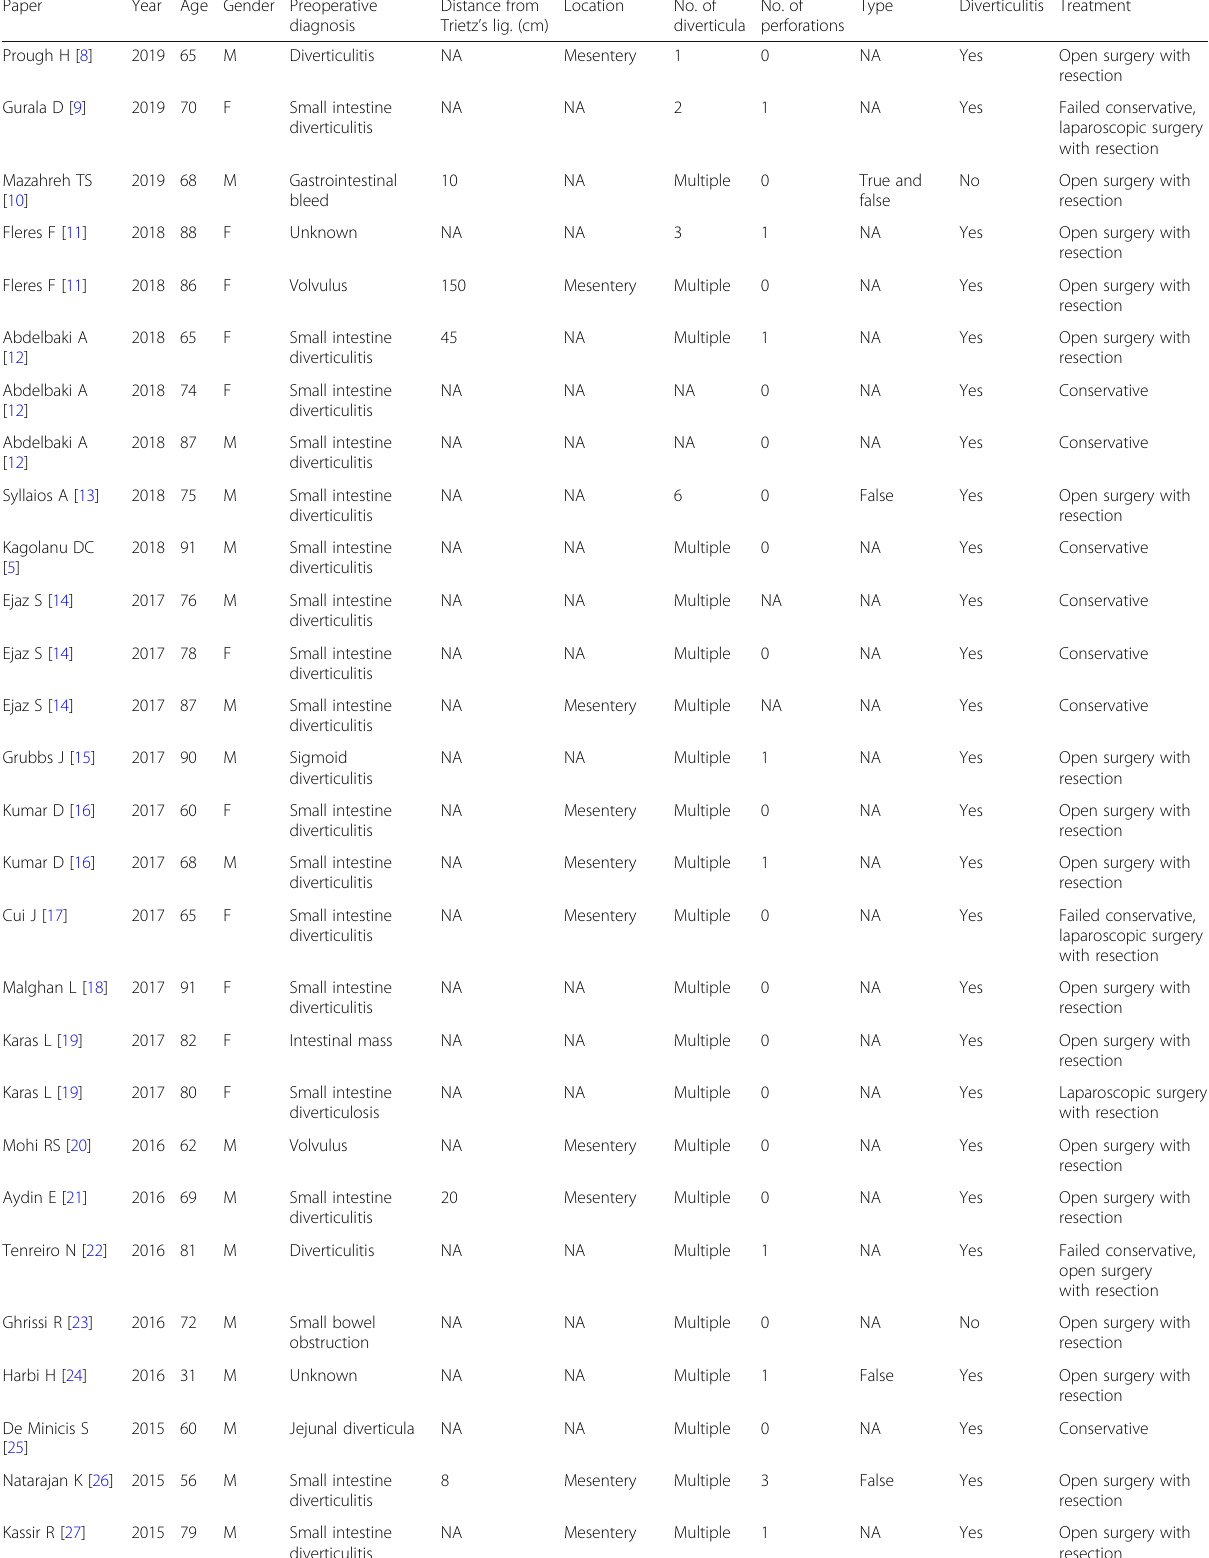
Table 1 Characteristics and treatment of jejunal diverticulosis in cases published between 2010 and 2020